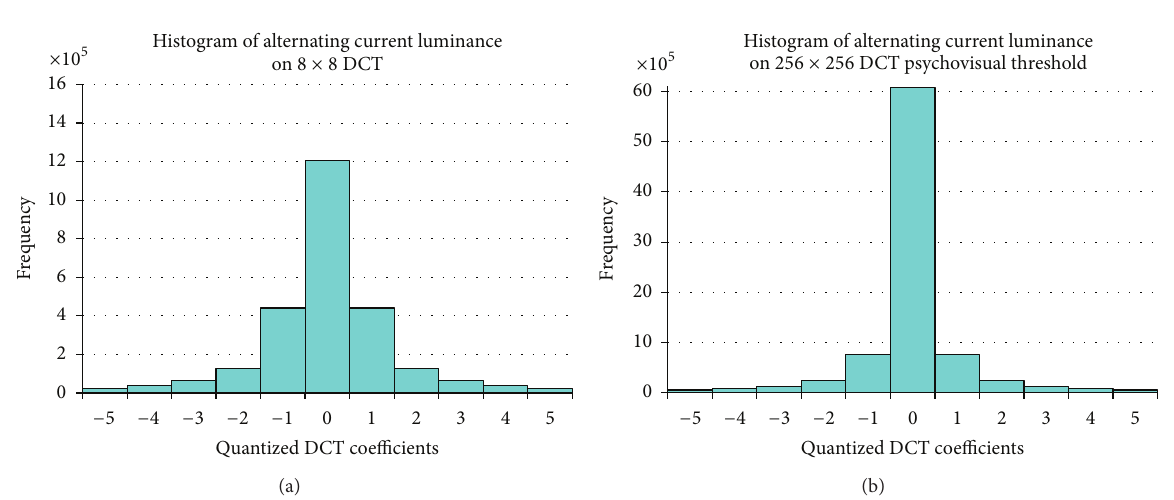
Figure6:Frequencydistributionofthealternatingcurrent(AC)coefficientsusing 8×8 DCTquantization(a)and 256×256 DCTquantization from psychovisual threshold (b) on luminance for 40 real